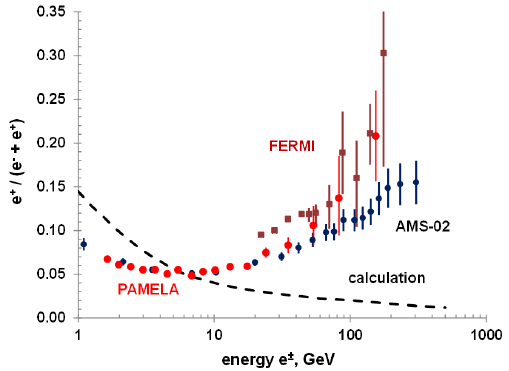
Figure 1. The positron fraction measured by PAMELA, AMS, Fermi LAT